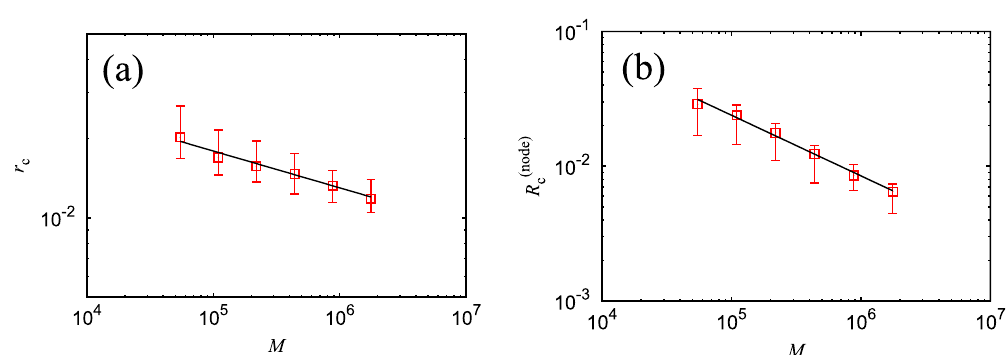
Figure 3. ( a ) The system size M vs, the ratio r c of the number of cartilage links to the total number of links in a log-log plot. The solid line shows the power exponents of 0.14. ( b ) The system size M vs, the normalized largest cluster size R c (node) immediately after removing all of the cartilage links in a log-log plot. The solid line shows the power exponents of